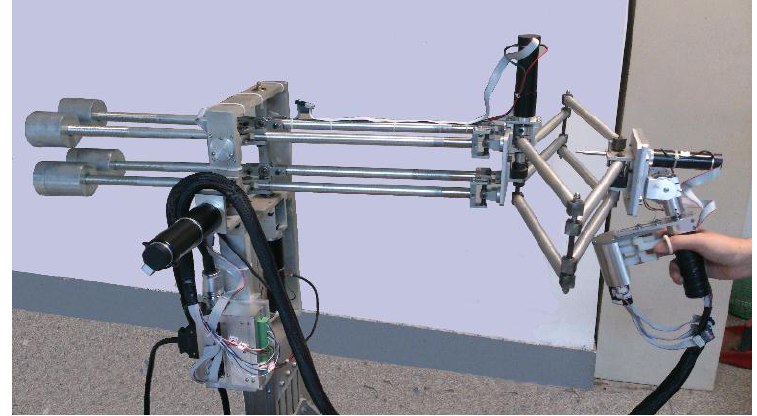
Figure 2. Overview of the haptic device.